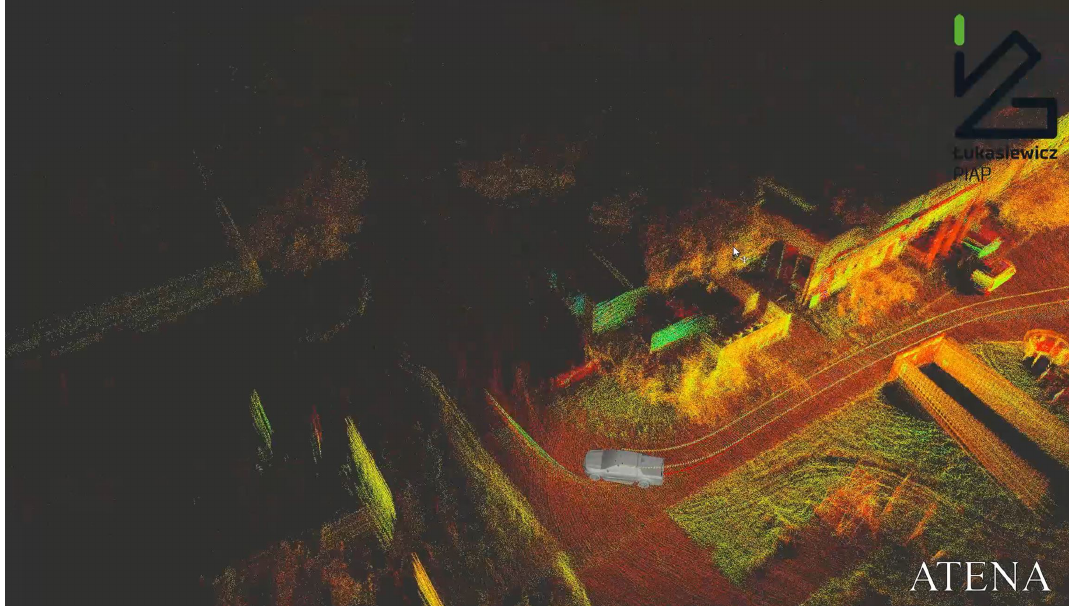
Figure 2. Łukasiewicz-PIAP ATENA demonstrator of technology in obtaining 3D data. An autonomous system based on the geometry rules is vulnerable to the wrong classification of single vegetation as a stiff obstacle that cannot be passed. This problem is well-known in the field of autonomous driving in rough terrain and could be one of the crucial problems to solve in the field of special and combat use of UGVs. An example of unstructured terrain is shown in Figure